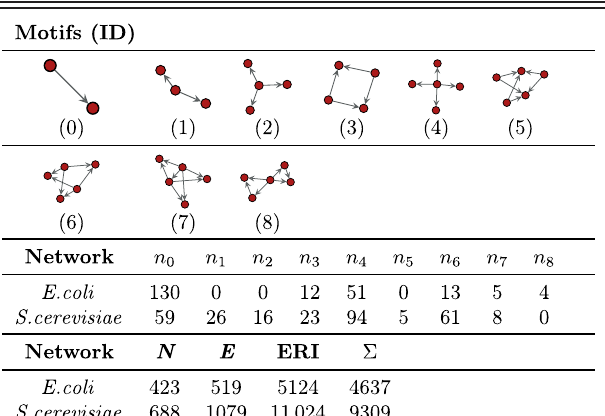
TABLE III. The motifs of the transcription networks of E. coli and S. cerevisiae obtained using all connected motifs up to size 5.